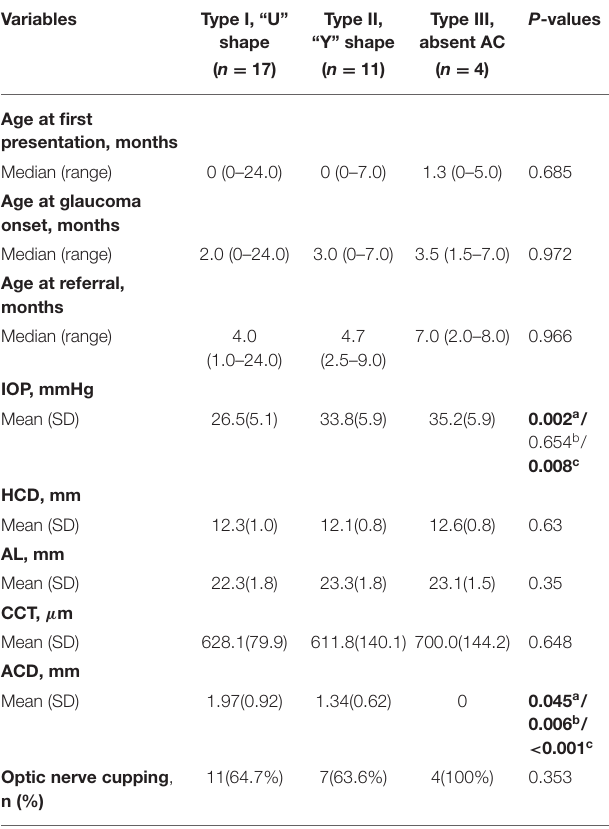
TABLE 3 | Comparison between different configurations of congenital fibrous pupillary membrane-induced secondary glaucoma.